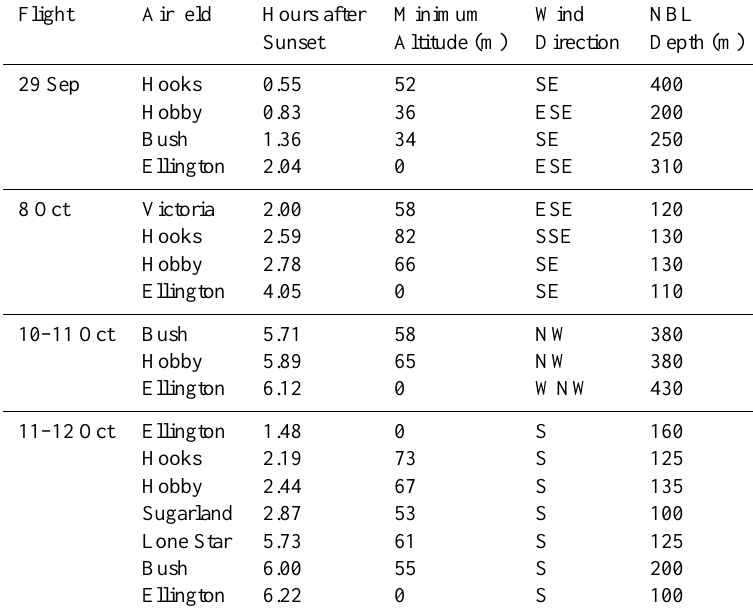
Table 1. Nighttime vertical profiles during TexAQS 2006.